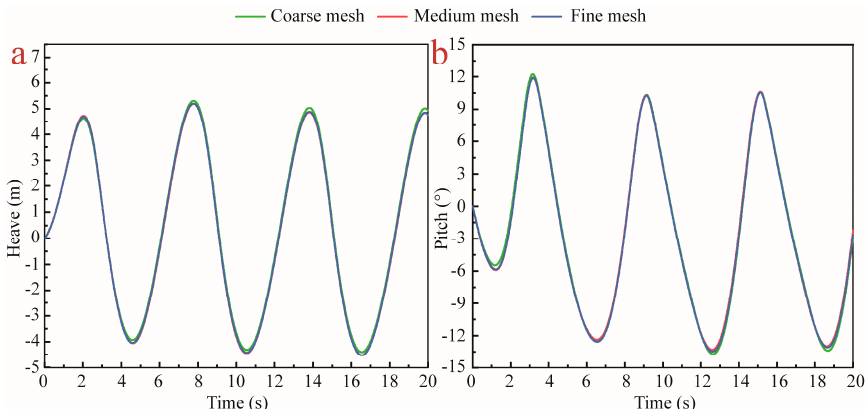
Figure 5. Heave and pitch motion plot of USV at 7 level sea state with different grids: ( a ) Heave motion, ( b ) Pitch.